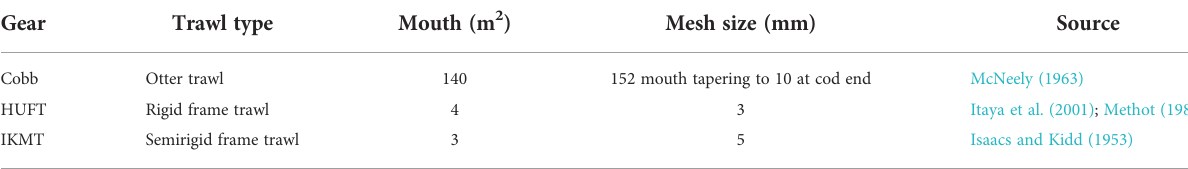
TABLE 1 Gear dimensions for the Cobb trawl, Hokkaido University frame trawl (HUFT), and Isaacs – Kidd midwater trawl (IKMT). Gear